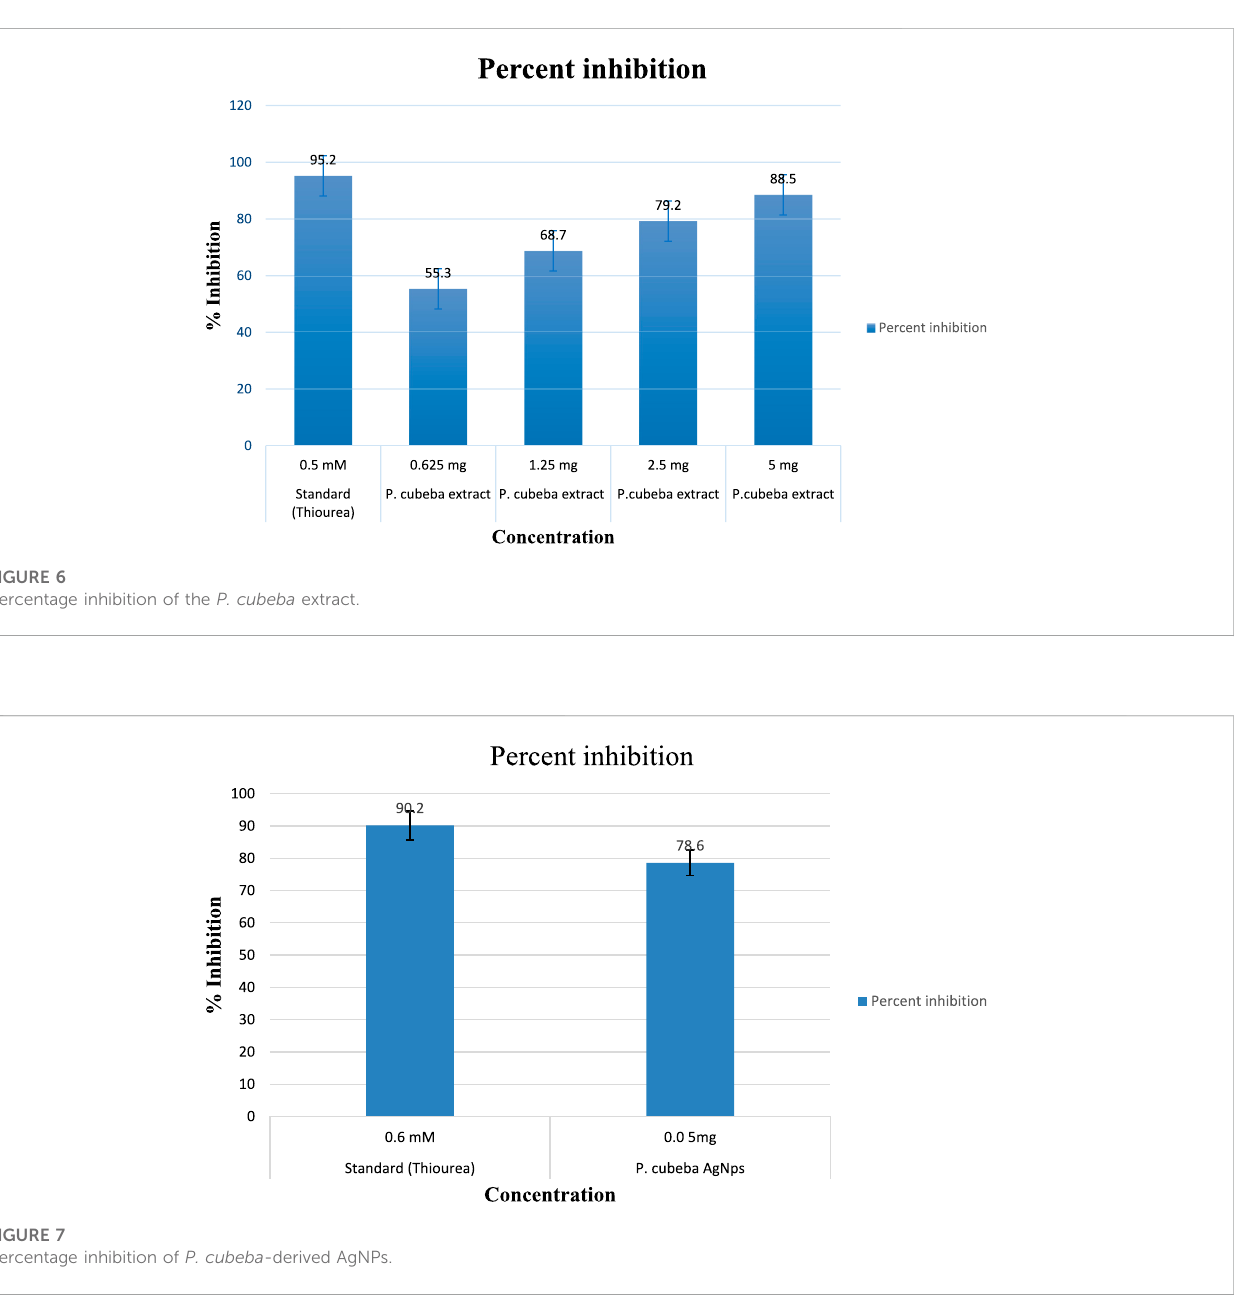
FIGURE 7 Percentage inhibition of P. cubeba -derived